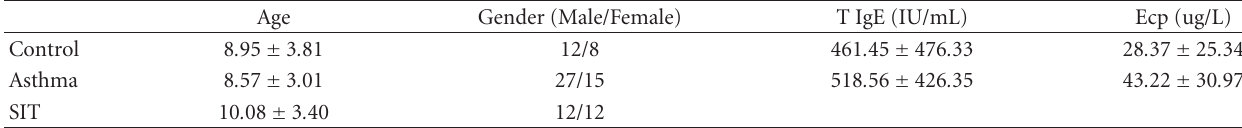
Table 1: Baseline characteristics of the patients.